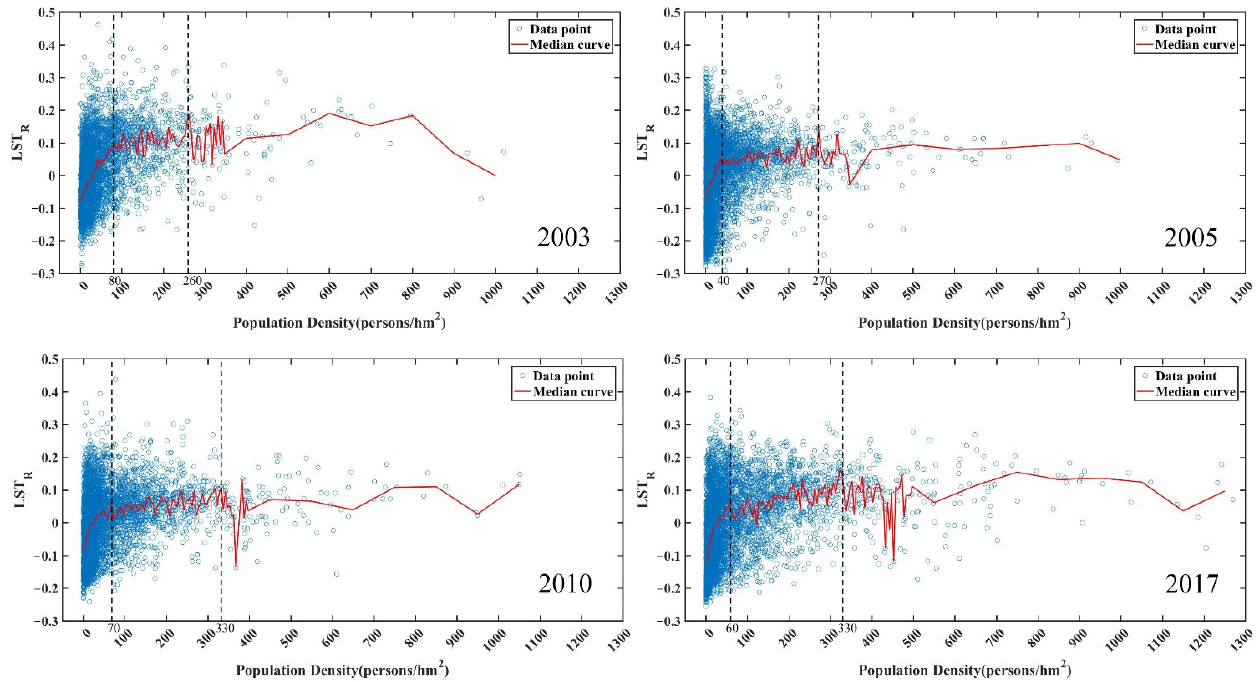
Figure 12. Scatter plot and median curve of LST R -population density (2003, 2005, 2010, and 2017). The scatter plots of LST R and population density for the four years showed a similar data distribution characteristic. Overall, LST R increased with increasing population density. The median curve of LST R had two turning points with increasing population